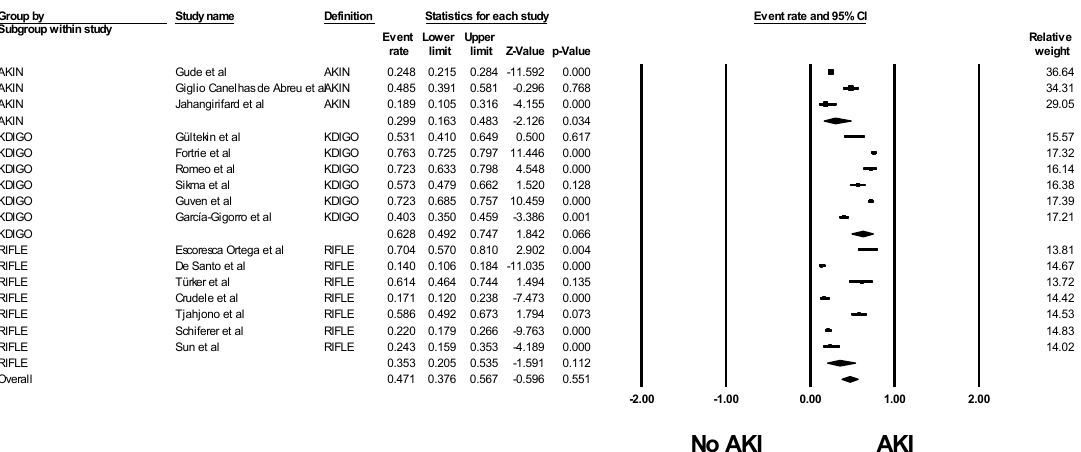
Figure 2. Forest plots of the included studies evaluating incidence of AKI among patients undergoing cardiac transplantation. A diamond data marker represents the overall rate from individual study (square data marker) and 95% CI.